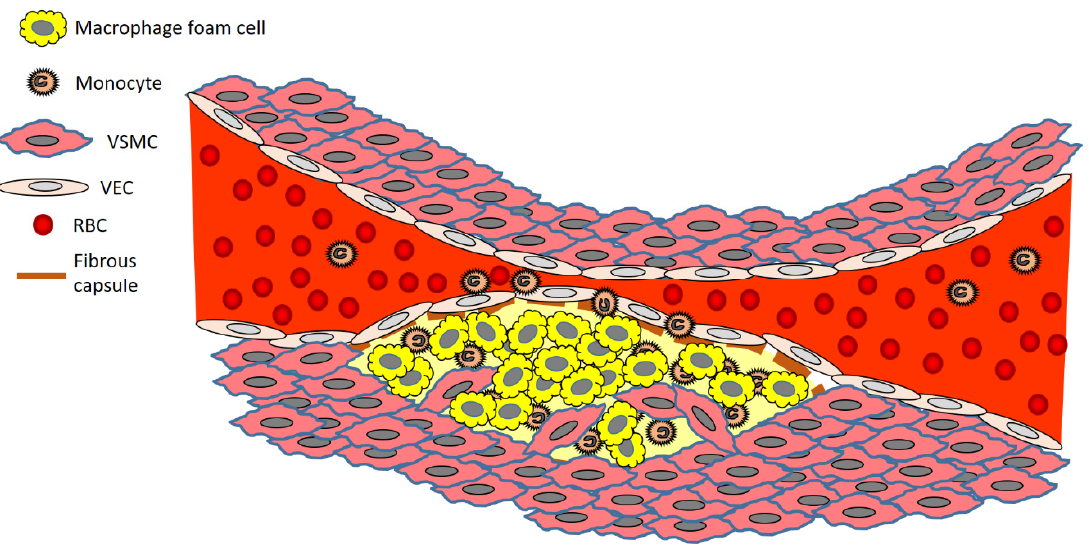
Figure 1. Brief overview of atherosclerosis development. Key: RBC, red blood cell; VEC, vascular endothelial cell; VSMC, vascular smooth muscle cell.